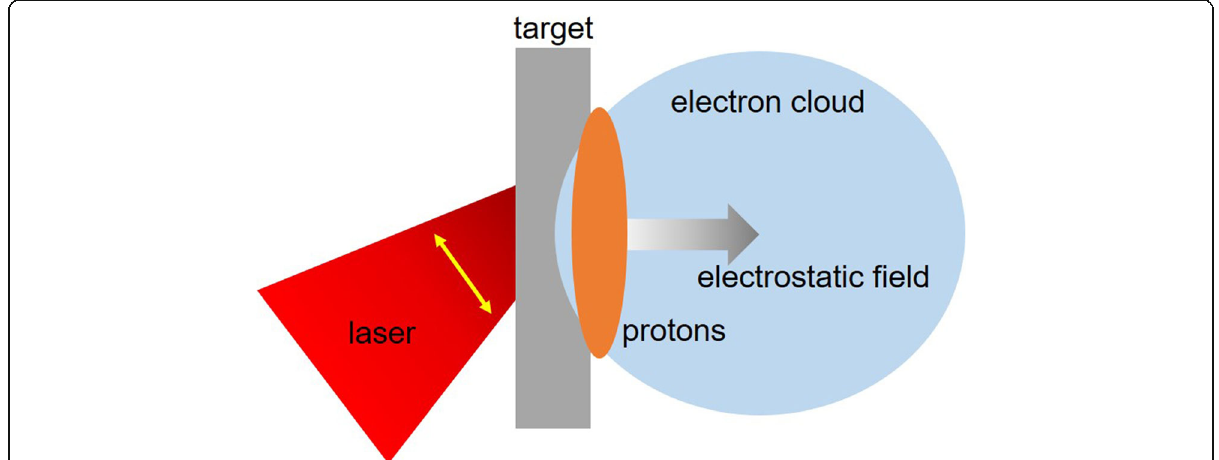
Fig. 17 Schematic illustration of the target normal sheath acceleration mechanism. A solid density target with a thickness of a few microns is irradiated with a P-polarized laser pulse